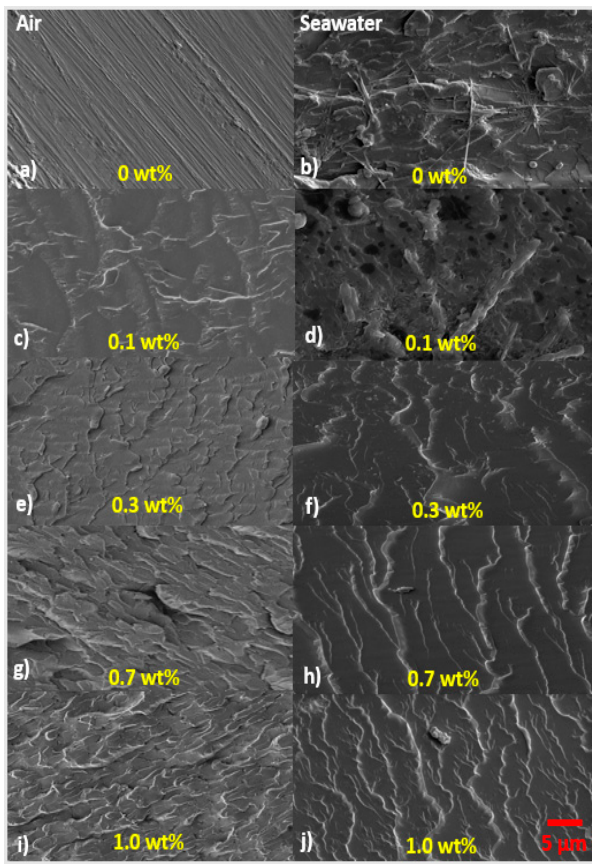
Figure 6. SEM micrographs of nanocomposites in air and after seawater exposure (scale at the bottom).